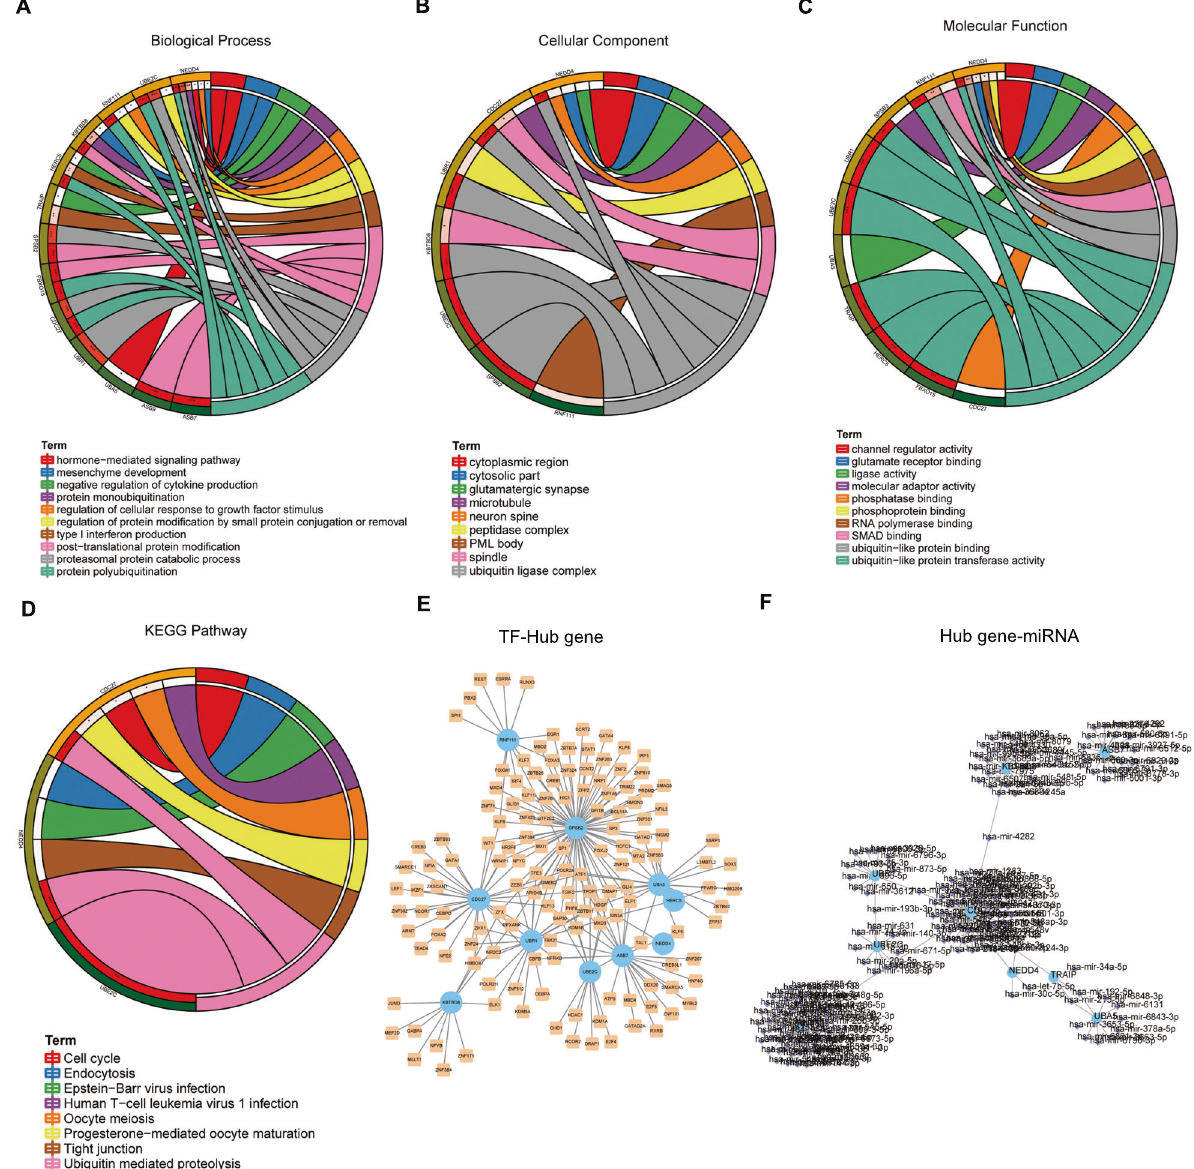
Fig. 2 Functional analyses of the hub genes. A Enriched biological processes among the hub genes. B Enriched cellular components among the hub genes. C Enriched molecular functions among the hub genes. D Enriched KEGG pathways among the hub genes. E The TF-hub gene network in Cytoscape. The blue dots represent hub genes, and the yellow dots represent TFs. F The hub gene-miRNA network in Cytoscape. The blue dots represent hub genes, and the purple dots represent